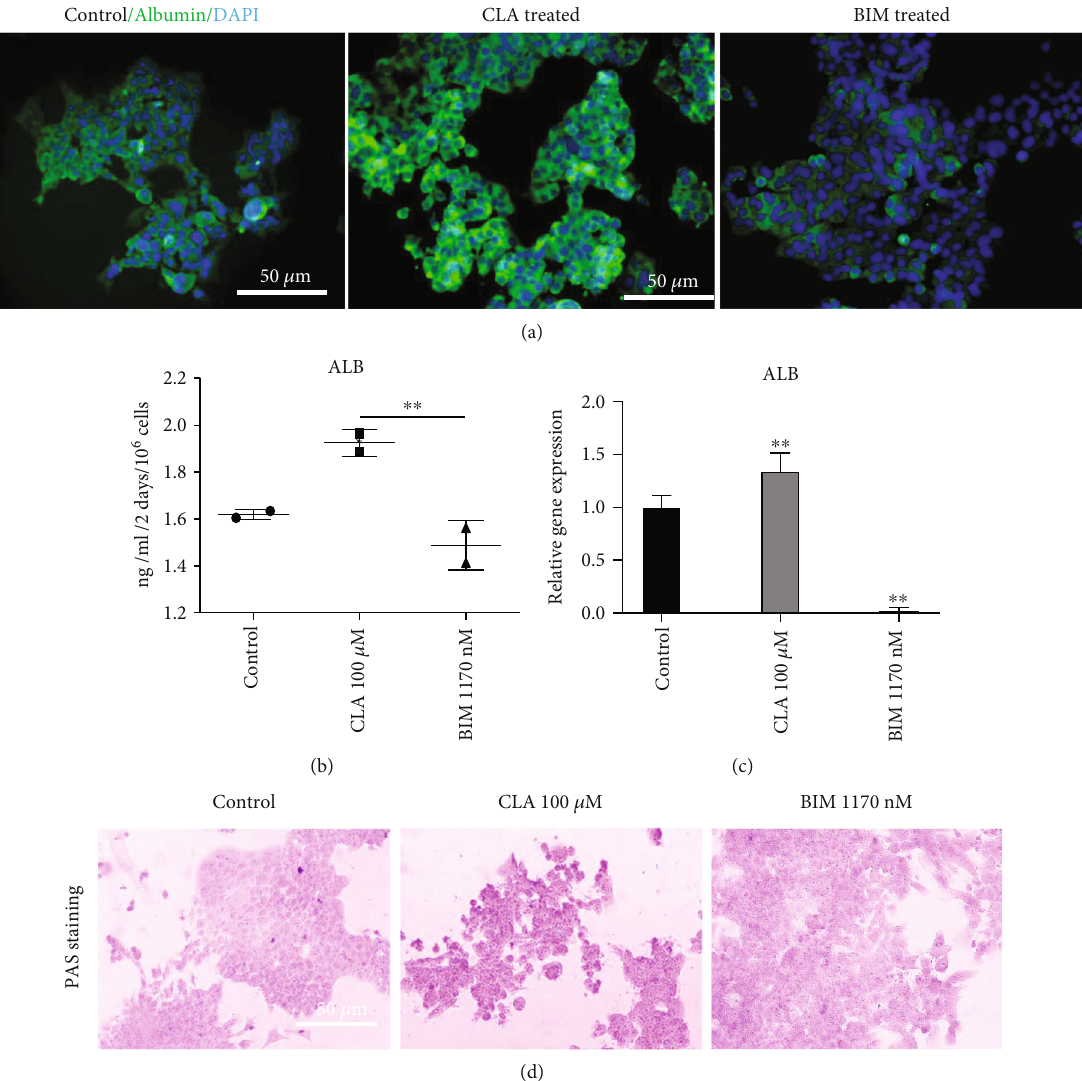
Figure 4: HNF4 α induction resulted in improved hepatocytic di ff erentiation of Hep-3B cells after CLA treatment. (a) Immuno fl uorescence staining revealed the remarkable expression of ALB in the CLA treated Hep-3B cells compared to the BIM treated and control group. (b) CLA treatment increased ALB secretion from Hep-3Bcells. (c) The relative mRNA expression of the ALB gene was increased after treatment with CLA in Hep-3B cells compared to the control group. (d) PAS staining showed glycogen accumulation in CLA treated cells as compared to BIM treated group. PAS: periodic acid-Schi ff staining. Data are presented as the mean ± SD , n = 3 ( ∗ p < 0 : 05 and ∗∗ p < 0 : 01